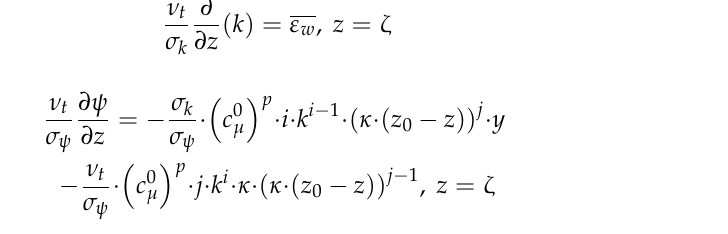
Table 1. Experiments for typhoon Megi to evaluate the relative and integrated impacts of turbulent mixing due to wave breaking (WB) and wave orbital motion (WOM). Expts. Description E0 Exclude WB and WOM